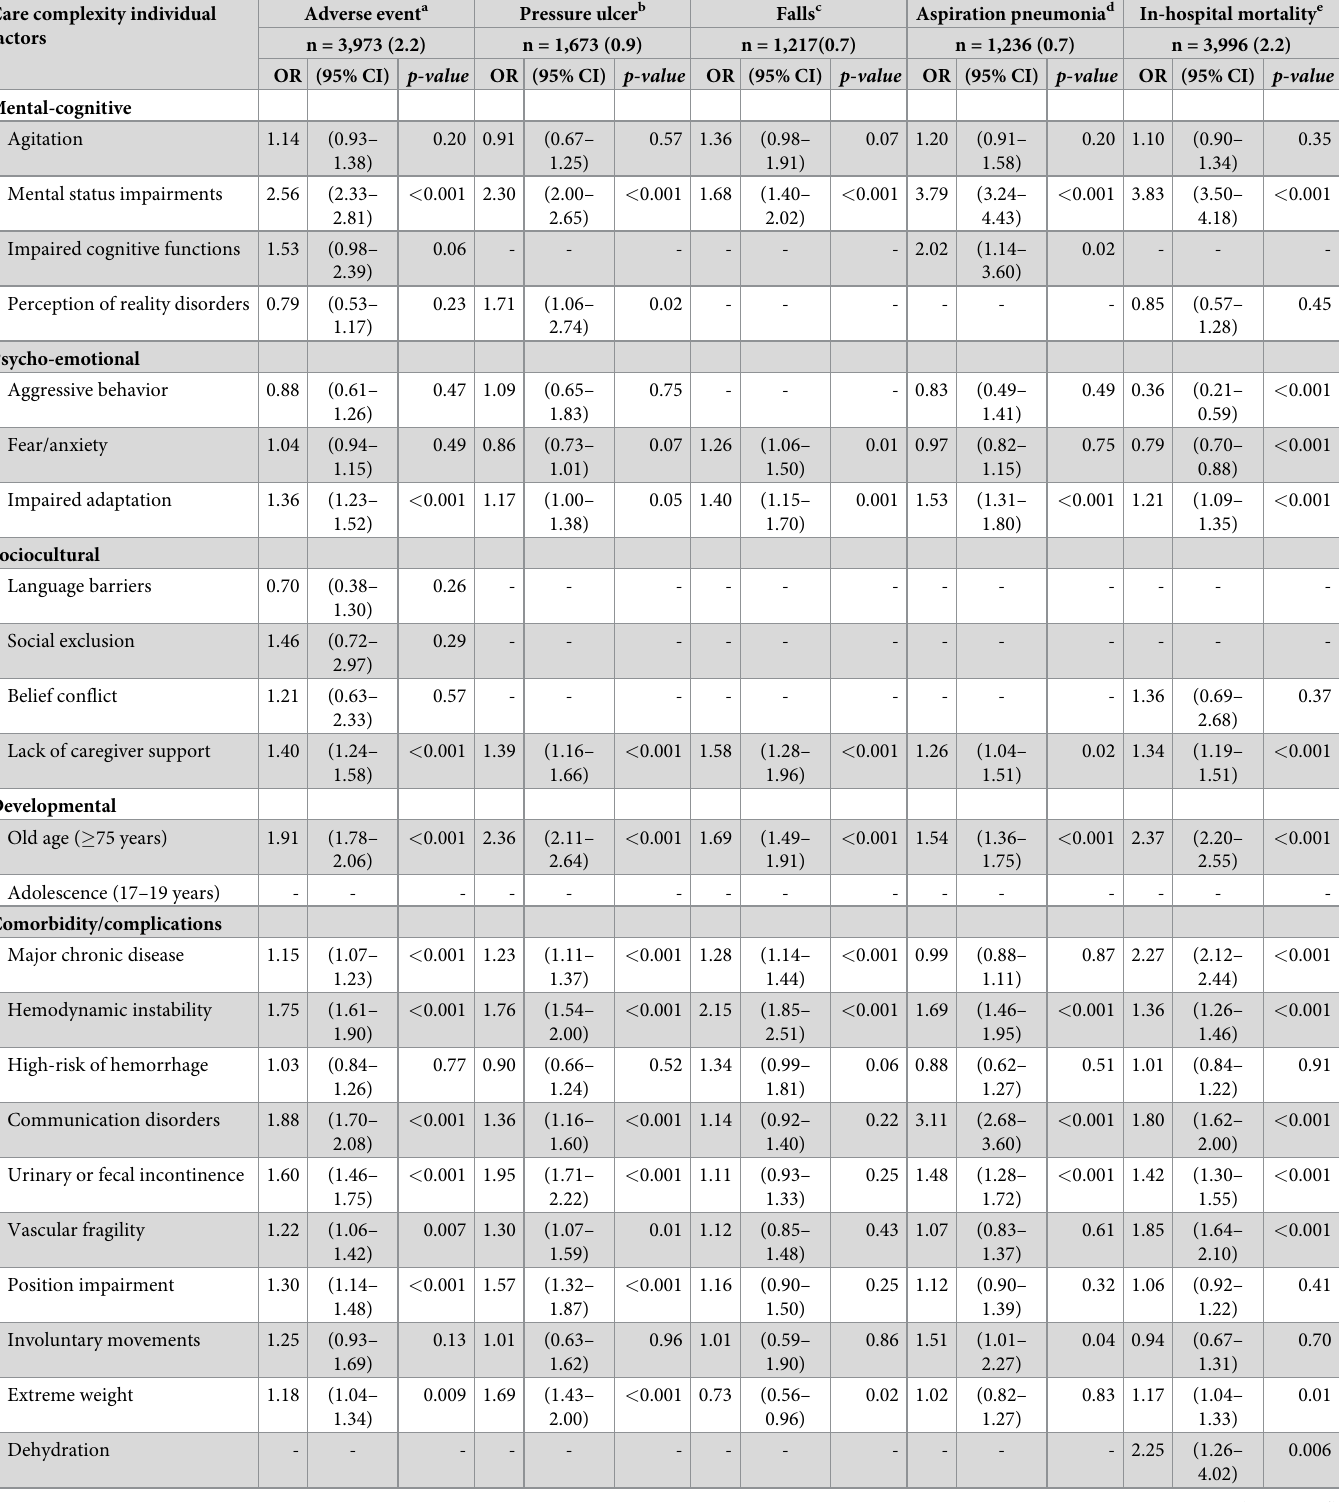
Table 3. Multivariate analysis of care complexity individual factors of adult hospitalized patients associated with adverse events and in-hospital